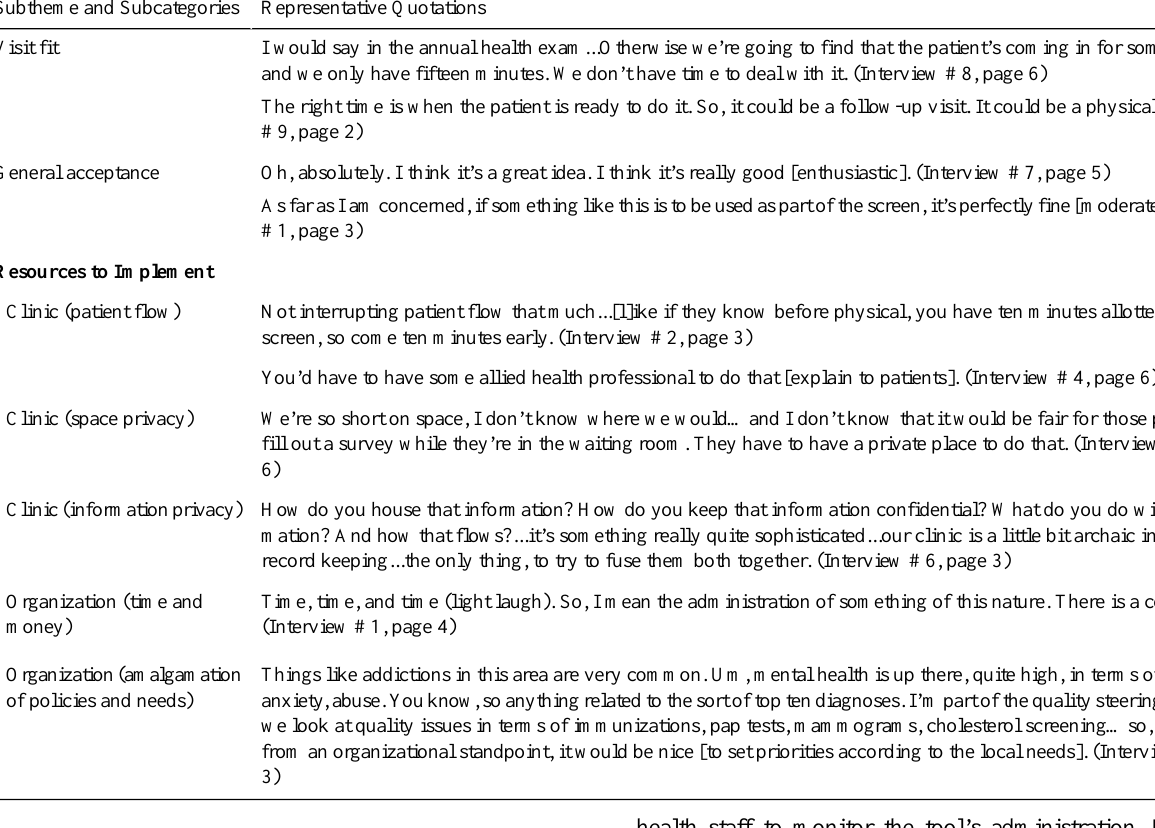
Table 3. Physician perceived feasibility of the computer-assisted HRA Representative QuotationsSubtheme and